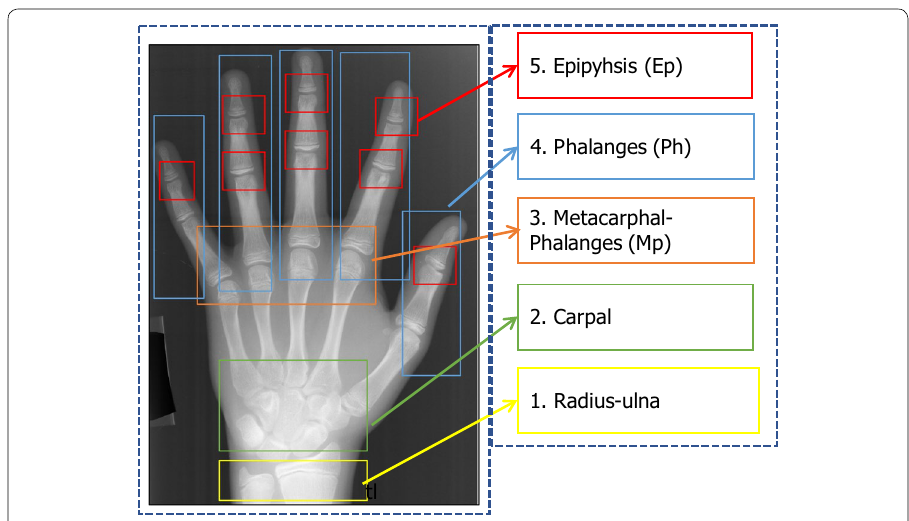
Fig. 1 ROI areas of hand